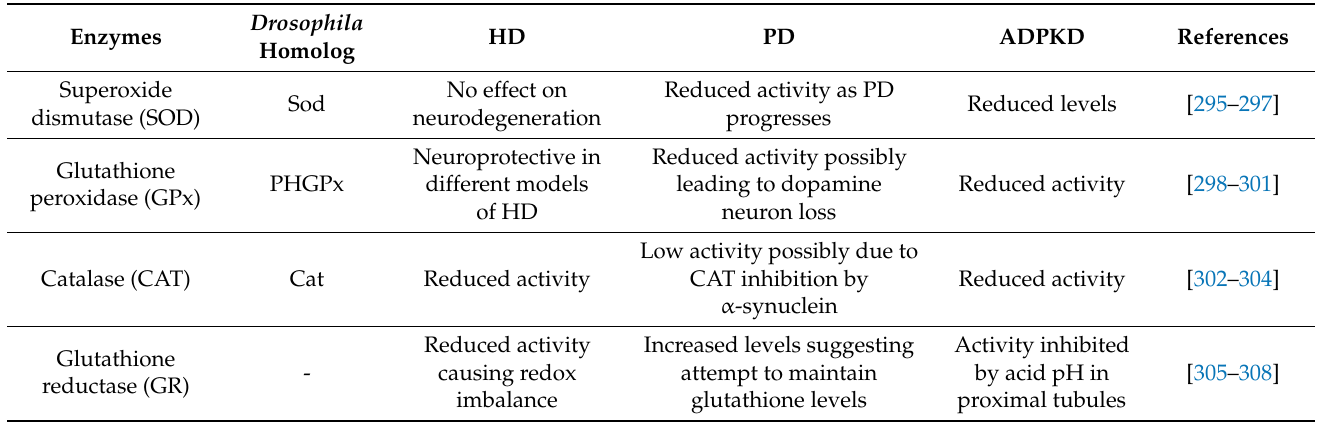
Table 2. Antioxidant enzymes influenced by melatonin *: Implications in Drosophila disease